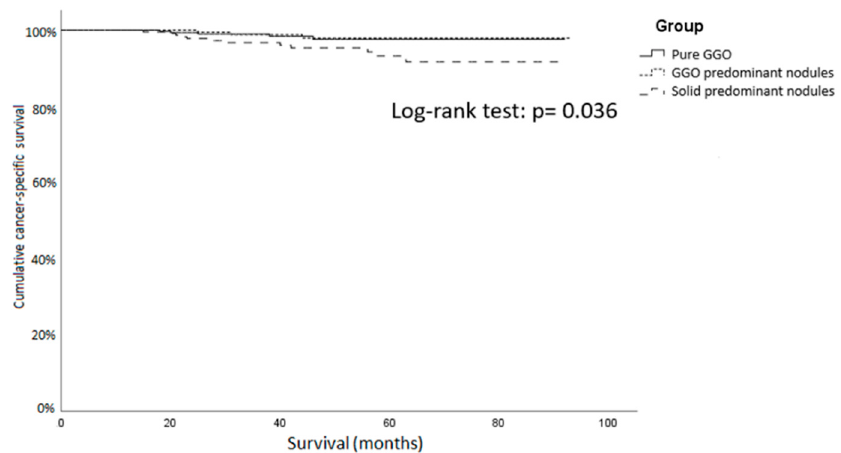
Figure 2. Cancer-specific survival curve of GGO patients with surgical resection. The pure GGO group and GGO predominant group showed a significantly longer cancer-specific survival than the solid predominant group. GGO: ground-glass opacity.